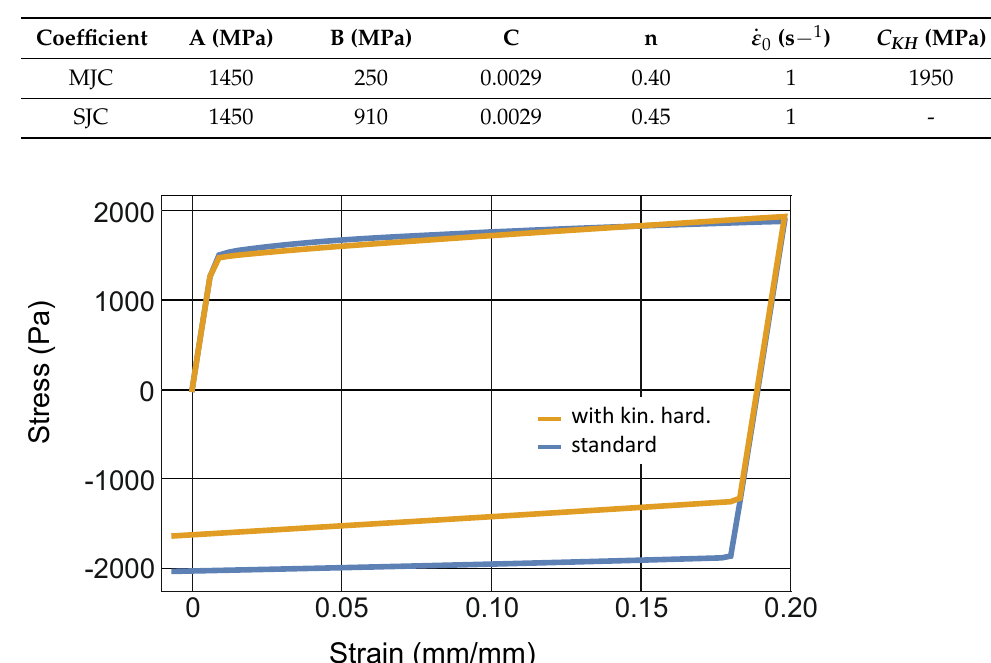
Table 1. Johnson-Cook constitutive model coefficient for AISI 4140 [20,21].